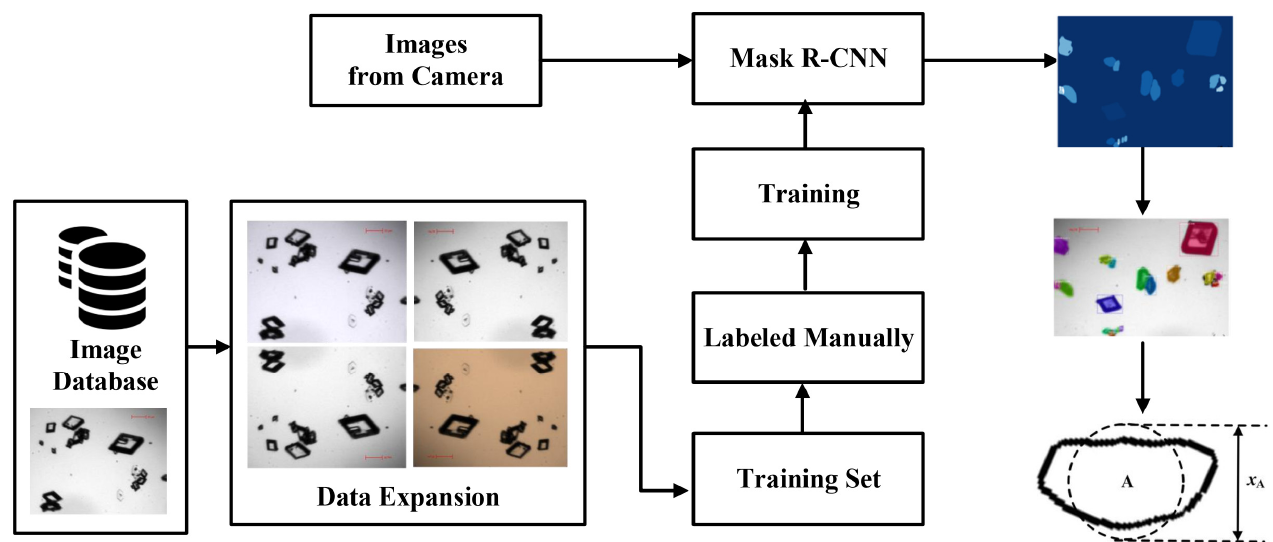
Figure 2. Real-time crystal image analysis process based on Mask R-CNN.